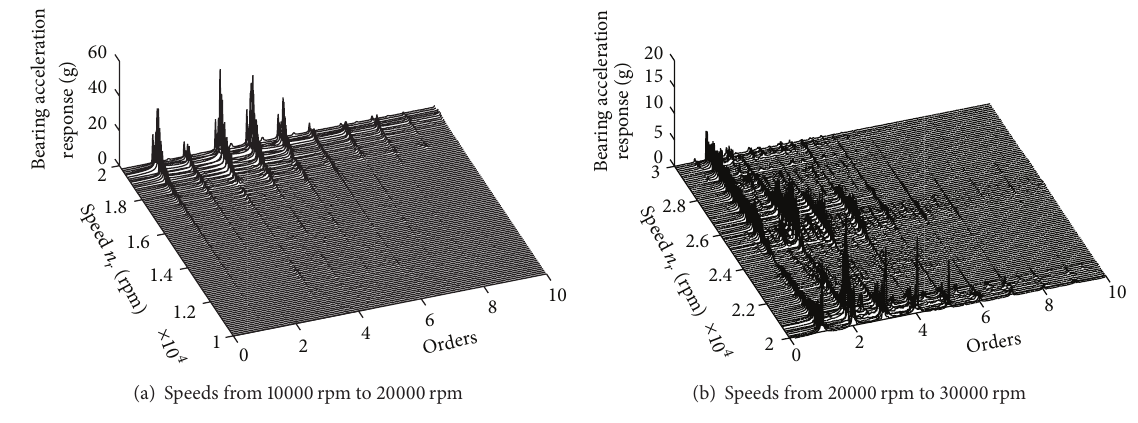
Figure 6: Cascade plot of the bearing housing acceleration response at different speeds.